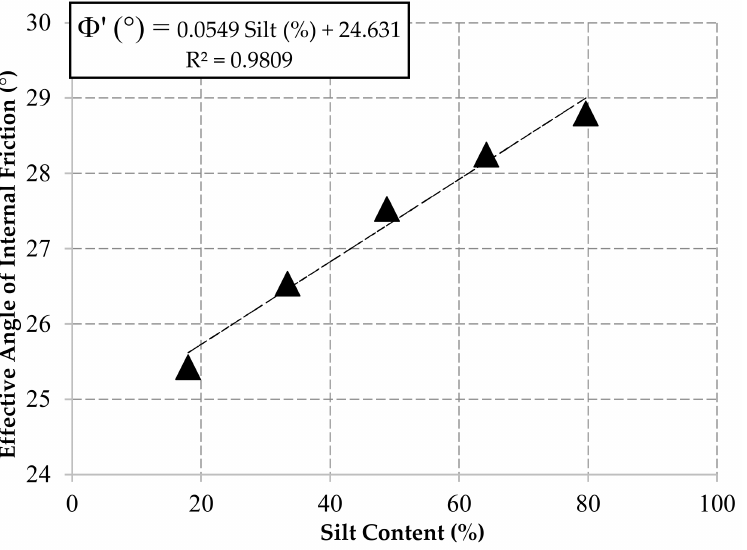
Figure 8. Correlation between effective internal friction angle and silt content. The semi-logarithmic plot of CSLs and NCLs derived from consolidated isotropic undrained shear triaxial compression testing results is shown in Figure 9. In the undrained shearing stage, the void ratio of each specimen remains constant. The water content of each tested specimen was measured as introduced previously. Therefore, the void ratio, as well as the specific volume in CSLs and NCLs, were determined. The effective stress paths shift to the left horizontally, as shown in Figure 9, because the drainage condition was undrained during the shear phase. It can be observed that the CSLs and NCLs are parallel, as shown in Figure 9, for the S1, S2, and S3 groups’ specimens. The gradients of the respective CSLs seem to be becoming non-parallel to the gradients of their corresponding NCLs with the increase in silt content, as indicated by the CSLs and NCLs of S4. For the S5 group specimens, the gradients of the CSLs are obviously not parallel to those of the NCLs, indicating that the silt particle content starts to dominate the behaviour of the soil. Therefore, it can be concluded that S1, S2, and S3 show typical clay behaviour, while S5 shows typical loose to medium-dense sand behaviour. S4 is in a transitional